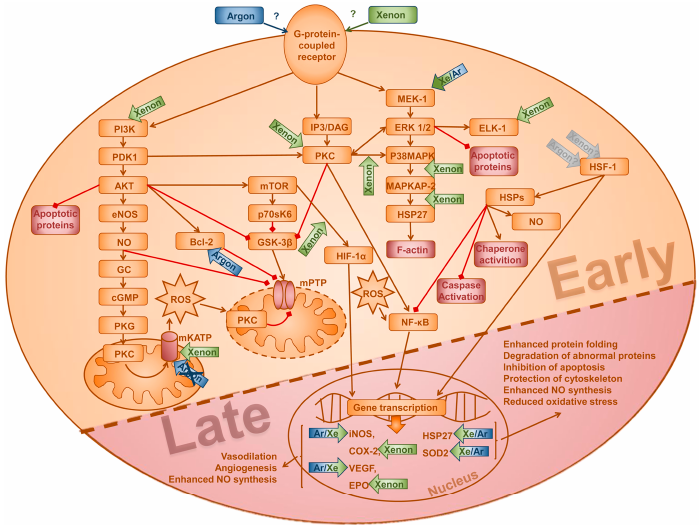
Figure 5. Supposed model of underlying mechanisms of protective effects of early and delayed preconditioning mediated by xenon and argon. This figure is a summary of previous studies that investigated the mechanisms of xenon and argon that may contribute to protection in the first and second window of preconditioning. Please note: this scheme does not comprise information about species, model (in vitro or in vivo), cell type, concentration or duration of argon or xenon. The plotted arrows for xenon (green) and argon (blue) indicate their up-regulatory properties on different kinases and molecules. Brown arrow-headed lines denote an activating effect, whereas red square-headed lines indicate a suppressive effect. PI3K, phosphoinositide 3-kinase; PDK1,